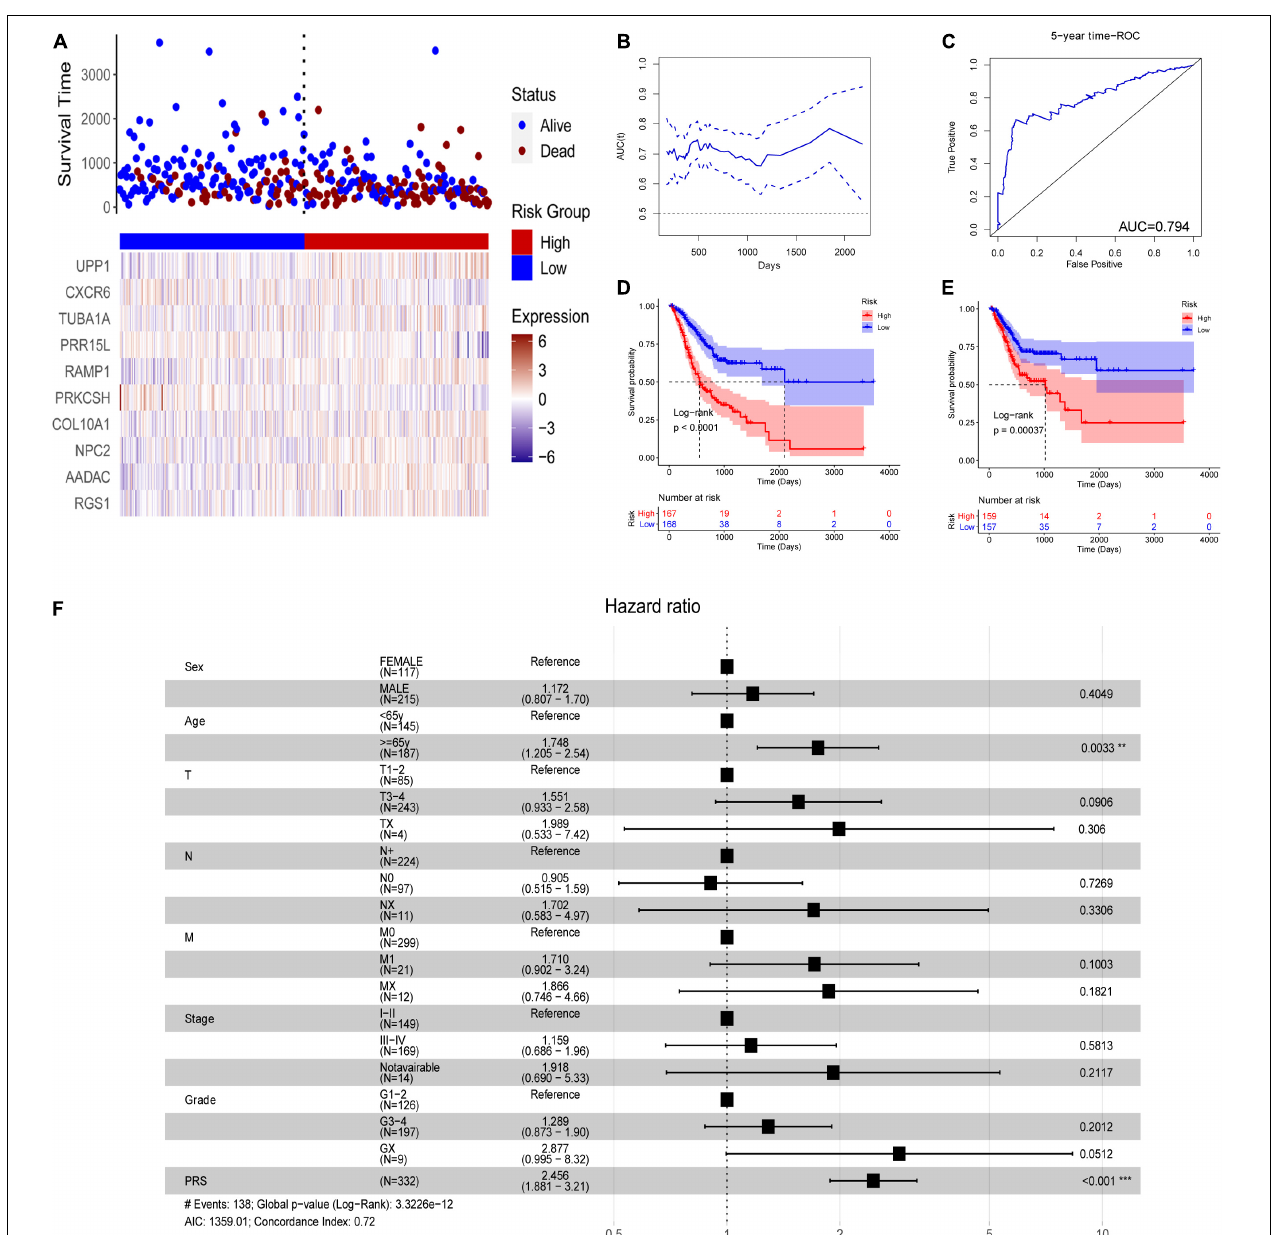
FIGURE 5 | The polygenic risk score (PRS) in the TCGA-STAD dataset. (A) Patients with STAD were divided into high- or low-risk groups according to the median PRS. (B) The areas under time-dependent receiver operating characteristic (ROC) curves. (C) 4-year ROC curve of the PRS. (D) overall survival (OS) analysis using Kaplan–Meier curves with the log-rank test. (E) progression-free survival (PFS) analysis using Kaplan–Meier curves with the log-rank test. (F) Multivariable Cox analysis of the PRS and routine clinicopathological characteristics. ** P < 0.01; *** P <